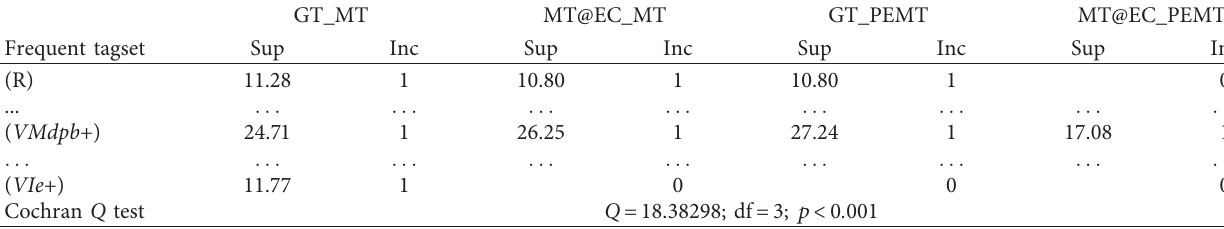
Table 2: Cochran Q test for incidence of frequent tagsets in examined